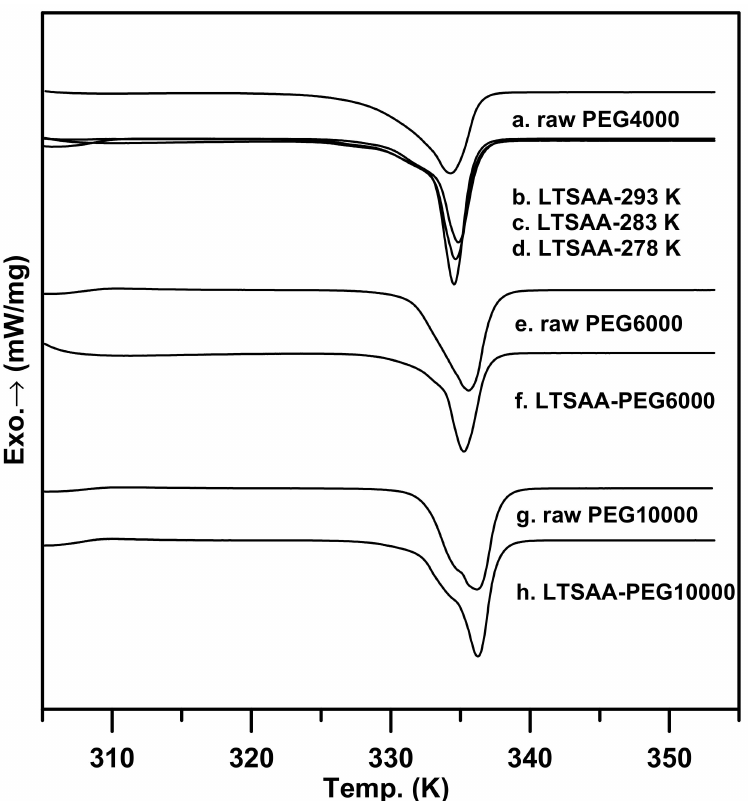
Figure 11. The DSC analyses of the PEG particles produced using